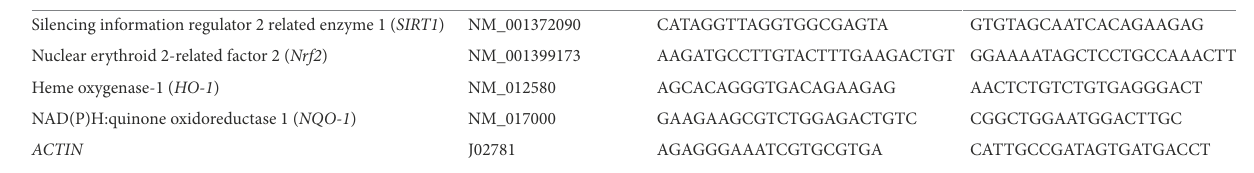
TABLE 1 Primer sequences used for